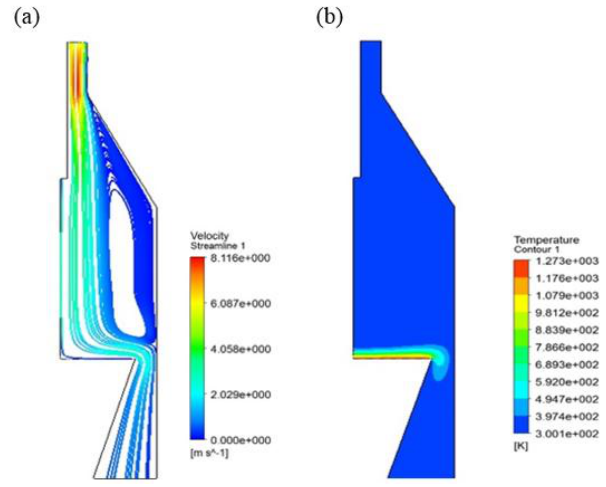
Figure 14. Schematic diagram of for Experiment 1, Case 2 ( a ) flow field and ( b ) thermal field.